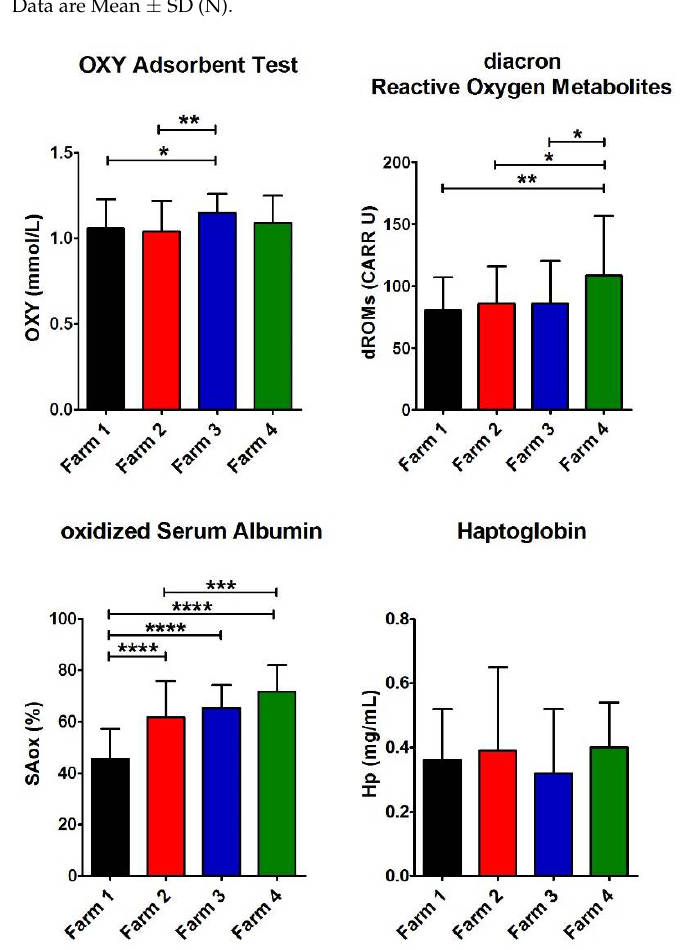
Figure 4. Values of biomarkers of oxidative stress. Histograms show the average for the four parameters measured for each farm (Farm 1–4). The error bars represent the standard deviations. At the top of the columns, the asterisks represent the p -values (see Materials and Methods) ( p ≤ 0.05 (*), p ≤ 0.01 (**), p ≤ 0.001 (***), and p ≤ 0.0001